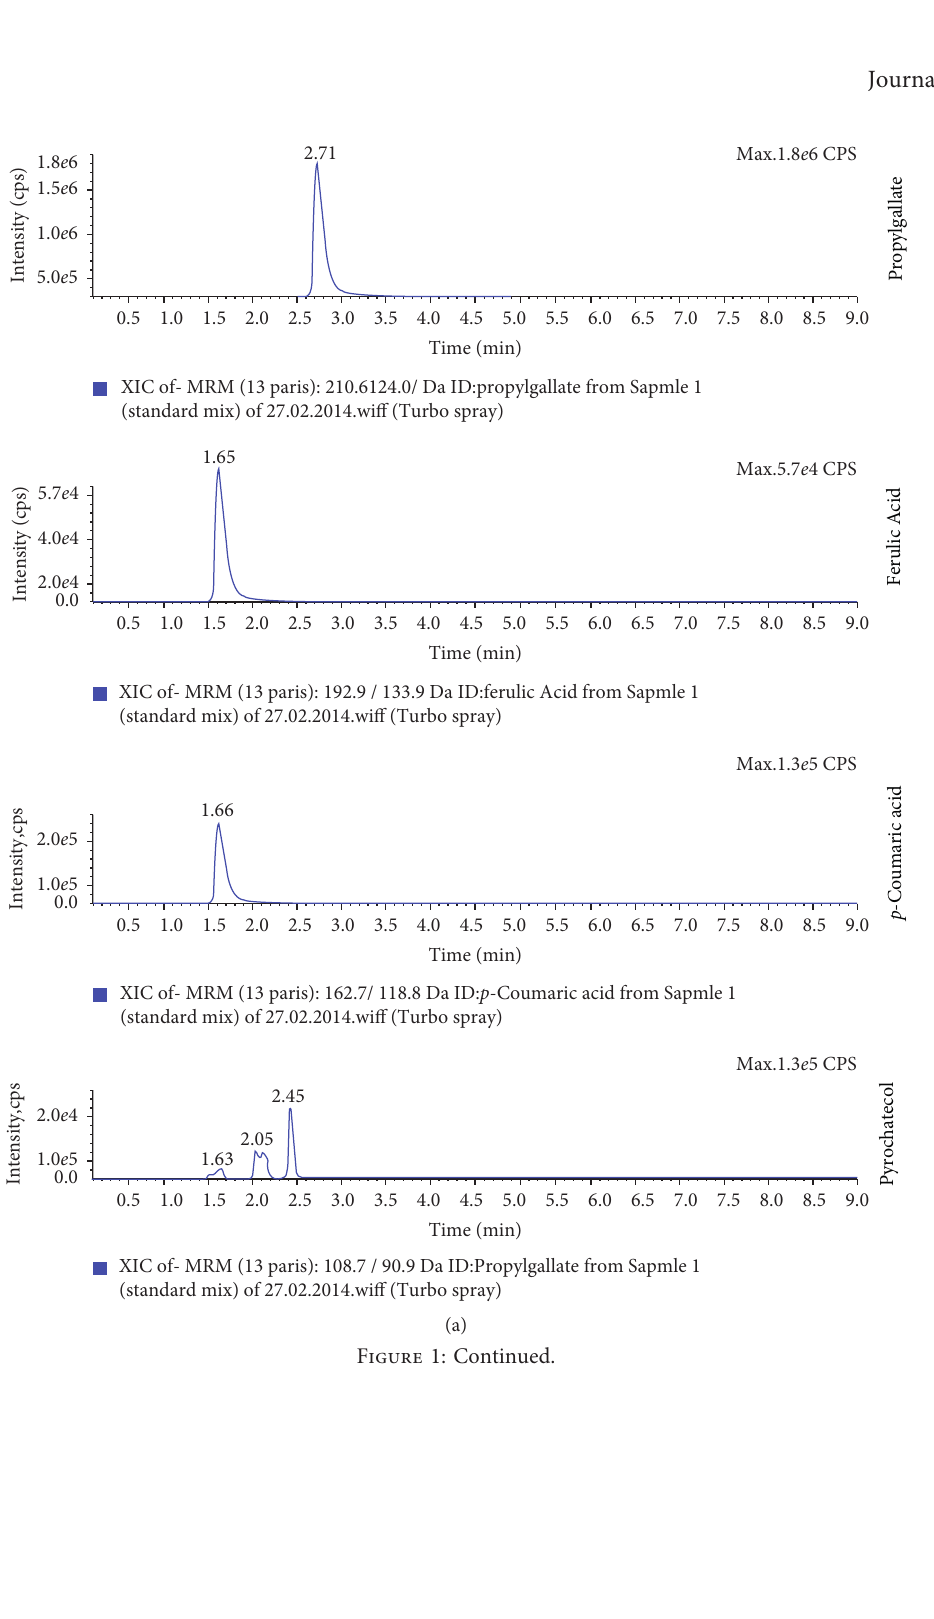
XIC of- MRM (13 paris): 108.7 / 90.9 Da ID:Propylgallate from Sapmle 1 (standard mix) of 27.02.2014.wiff (Turbo